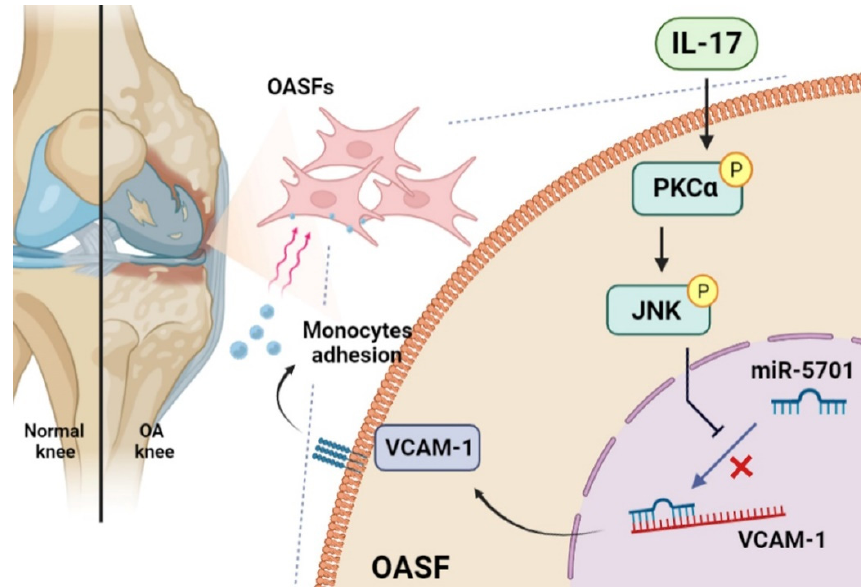
Figure 6. Schematic diagram summarizes the mechanisms by which IL-17 facilitates VCAM-1 production and monocyte adhesion in human OASFs. IL-17 promotes VCAM-1 synthesis and enhances monocyte adhesion in human OASFs by suppressing miR-5701 production in the PKC- α and JNK signaling